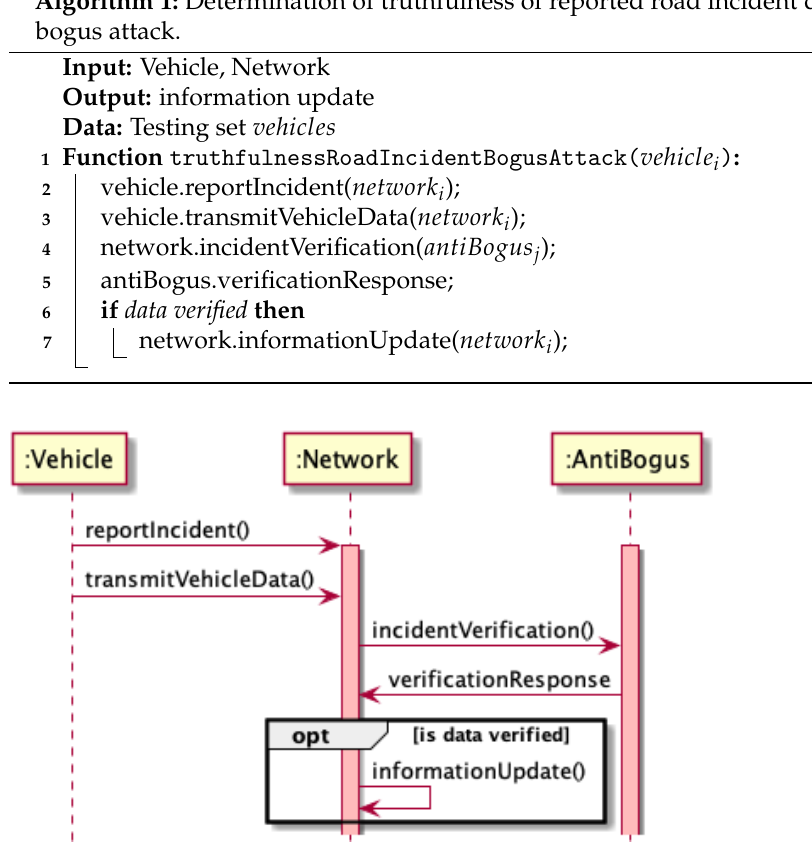
Figure 4. Determination of truthfulness of reported road incident during a bogus